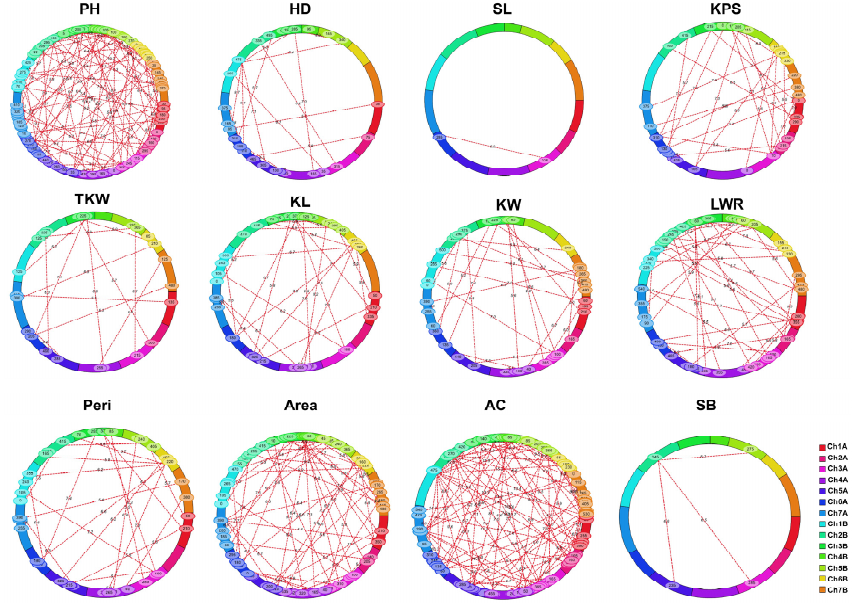
Figure 3. Detection of epistatic QTLs for the 12 traits. LOD value = 5.5.